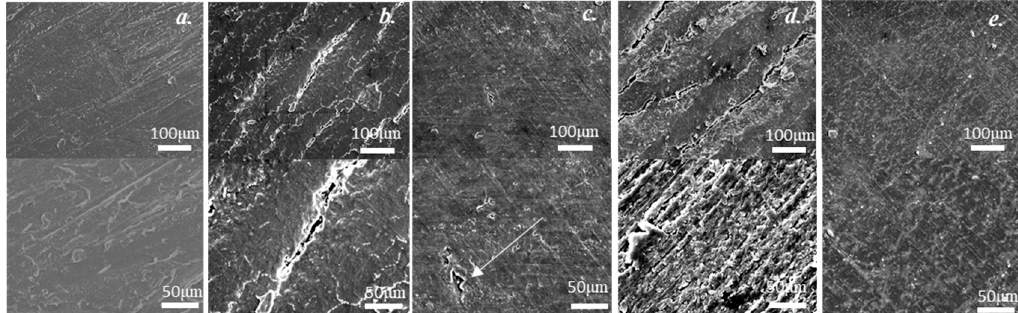
Figure 4. Scanning electron microscope (SEM) images of the RS original resin and the RS hot-rolled resins with the different treatments and 50% reduction ratio: ( a ) the original RS resin; ( b ) the RS hot- rolled resin without treatment; ( c ) the RS hot-rolled resin with 40 vol% ethanol treatment; ( d ) The RS hot-rolled resin with 100 vol% ethanol treatment; ( e ) the RS hot-rolled resin with boiling